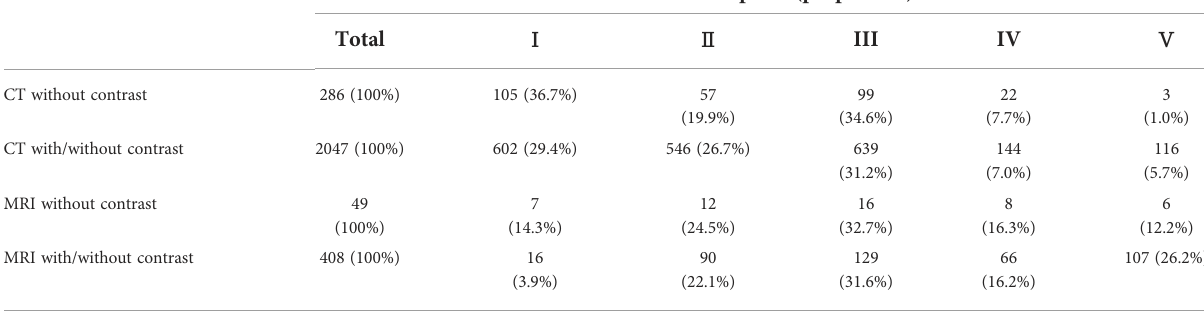
TABLE 1 Dataset in each diagnosis category according to the different examination methods. Method of